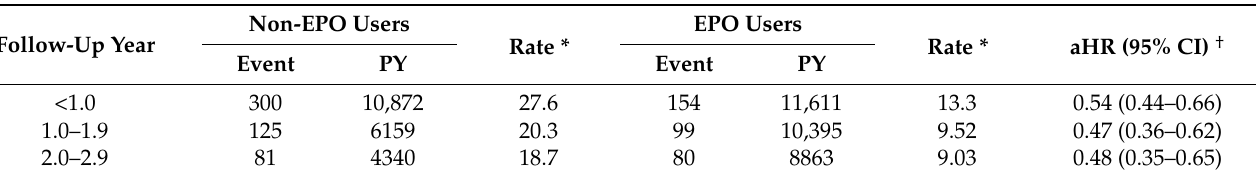
Table 4. Incidence and hazard ratios of age-related macular degeneration in hemodialysis patients treated with erythropoietin by follow-up